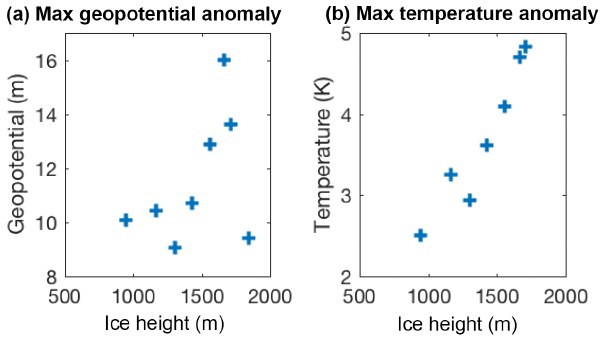
Figure 10. Scatter plots of summer (JJA) maximum (a) temperature anomaly and (b) geopotential height anomaly over Baffin Island vs. maximum ice elevation in each